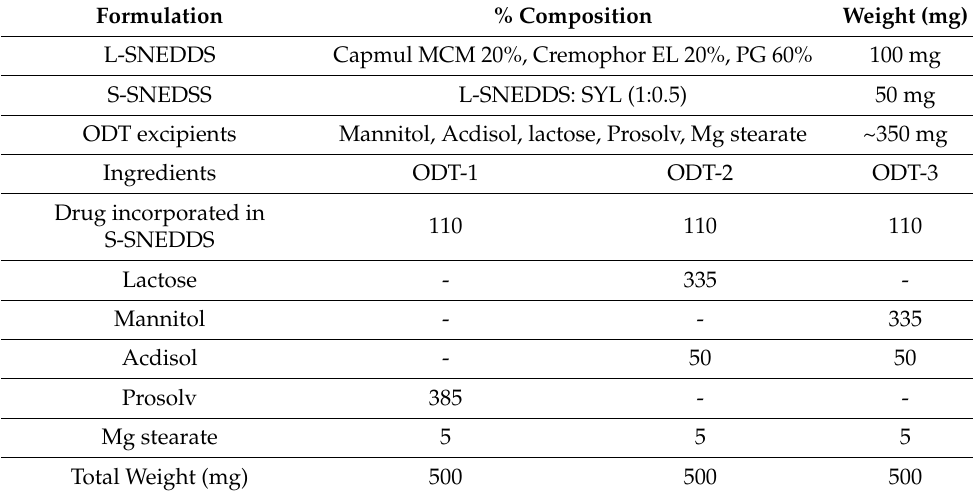
Table 7. Composition of prepared ODT